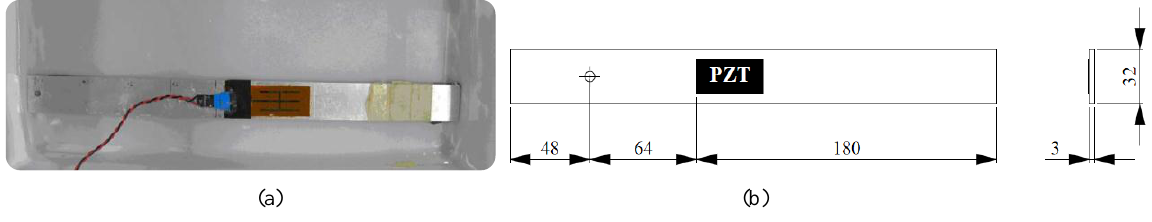
Fig. 8. (a) Experimental assembly; (b) Geometry of the specimen and position of the PZT patch.